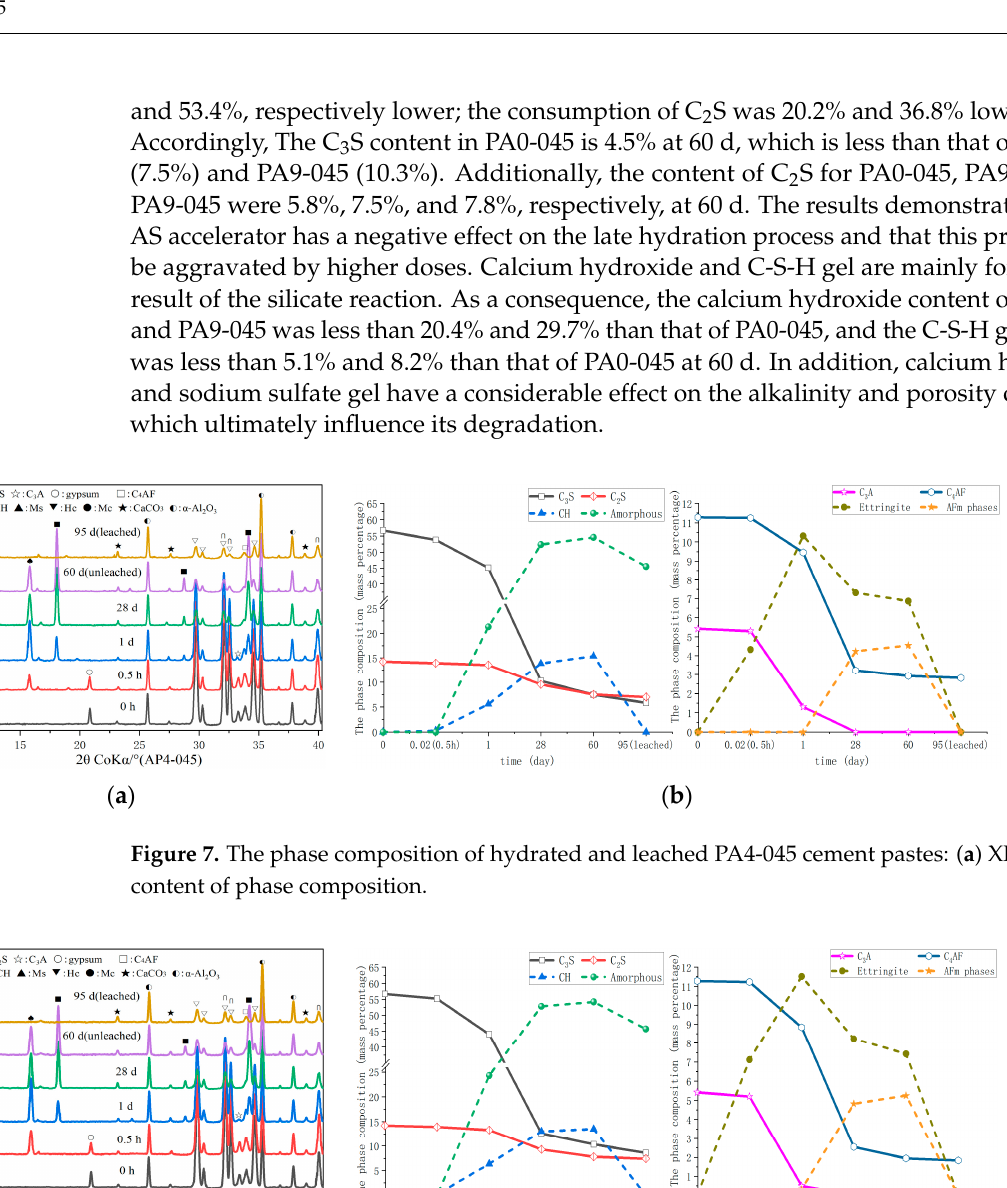
Figure 8. The phase composition of hydrated and leached PA9-045 cement pastes: ( a ) XRD; ( b ) the content of phase composition.